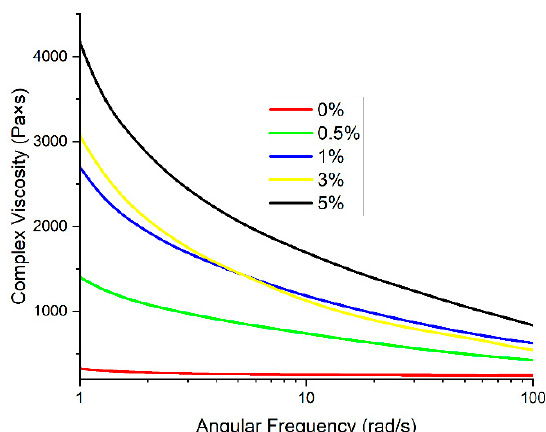
Figure 2. Dependence of the melt viscosity on angular frequency for R-BAPB modified with VGCF.